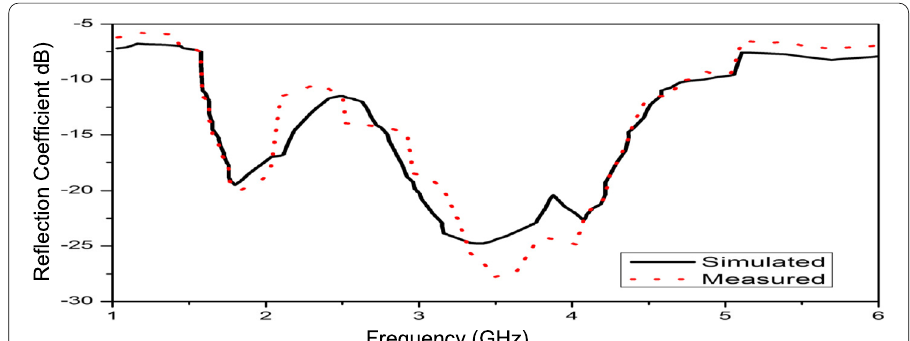
Fig. 14 Simulated and measured reflection coefficient of proposed antenna with 11 layers of metamaterial